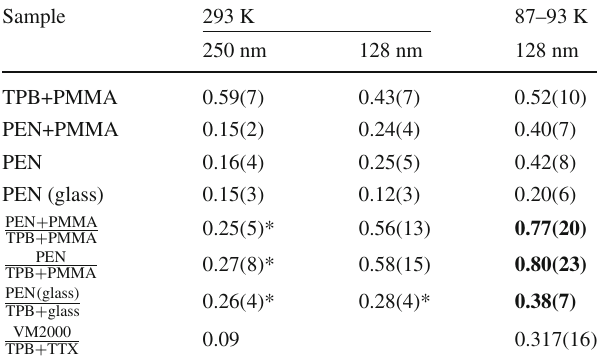
Table 1 Absolute WLSE for TPB+PMMA [10], PEN+PMMA, standalone PEN and PEN+glass, and relative efficiencies w.r.t. TPB+substrate. Values indicated with asterisks are directly measured in this work; the rest relies on literature based inference (see text for details). Results supporting the key conclusuions (see text) are shown in bold. The last row shows experimental ratios of fluorescence yield of VM2000 and approx. 1 mg/cm 2 thick TPB coatings evaporated on Tetratex ® (TTX), with the 87 K value measured with an LAr detector from Ref.